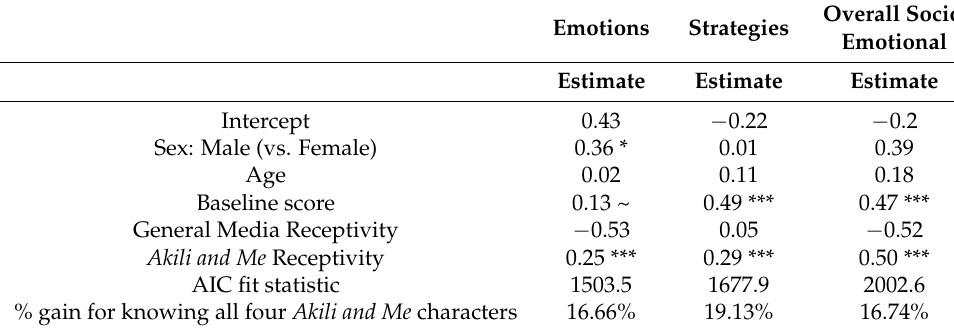
Table 3. Models predicting the socio-emotional outcomes, exploring Akili and Me